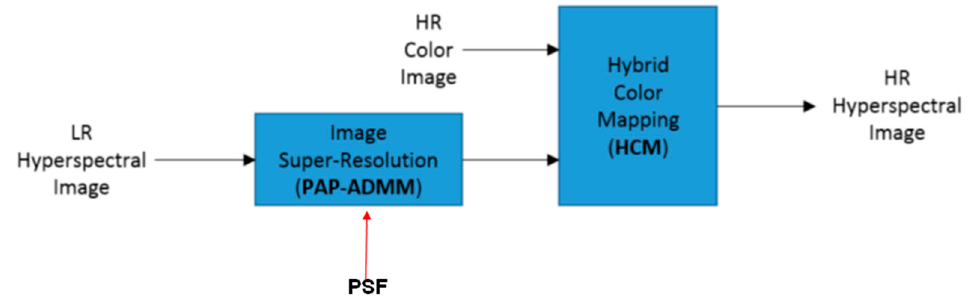
Figure 1. Outline of the proposed method. We use hybrid color mapping (HCM) to fuse low-resolution (LR) and high-resolution (HR) images. For LR images, we use a single-image super-resolution algorithm where PSF is incorporated to first enhance the resolution before feeding to the HCM.